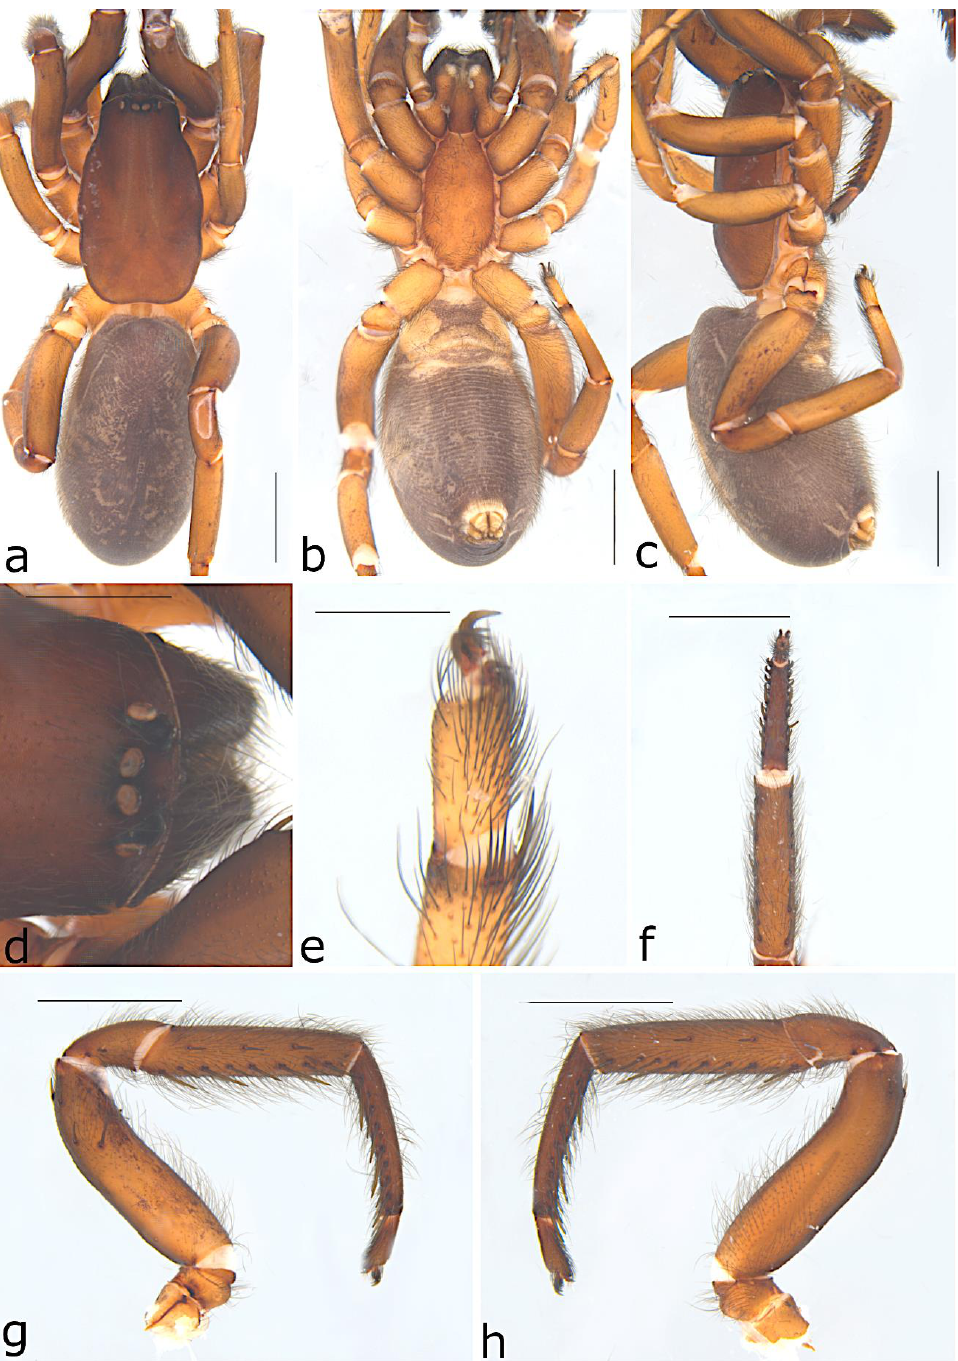
Figure 24. Ariadna umbra sp. nov. ♀ paratype (SAMA NN30624) from Naracoorte (SA): ( a ) habitus, dorsal view; ( b ) same, ventral view; ( c ) same, lateral view; ( d ) eyes, dorsal view; ( e ) left metatarsus IV, preening comb, retrolateral view; ( f ) left leg I, ventral view; ( g ) same, prolateral view; ( h ) same, retrolateral view. Scale bars ( a – d ) = 2 mm, ( e ) = 0.5 mm and ( f – h ) = 2 mm.